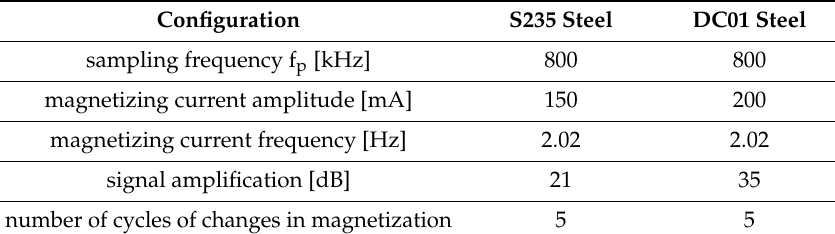
Table 2. Details of measuring configurations.